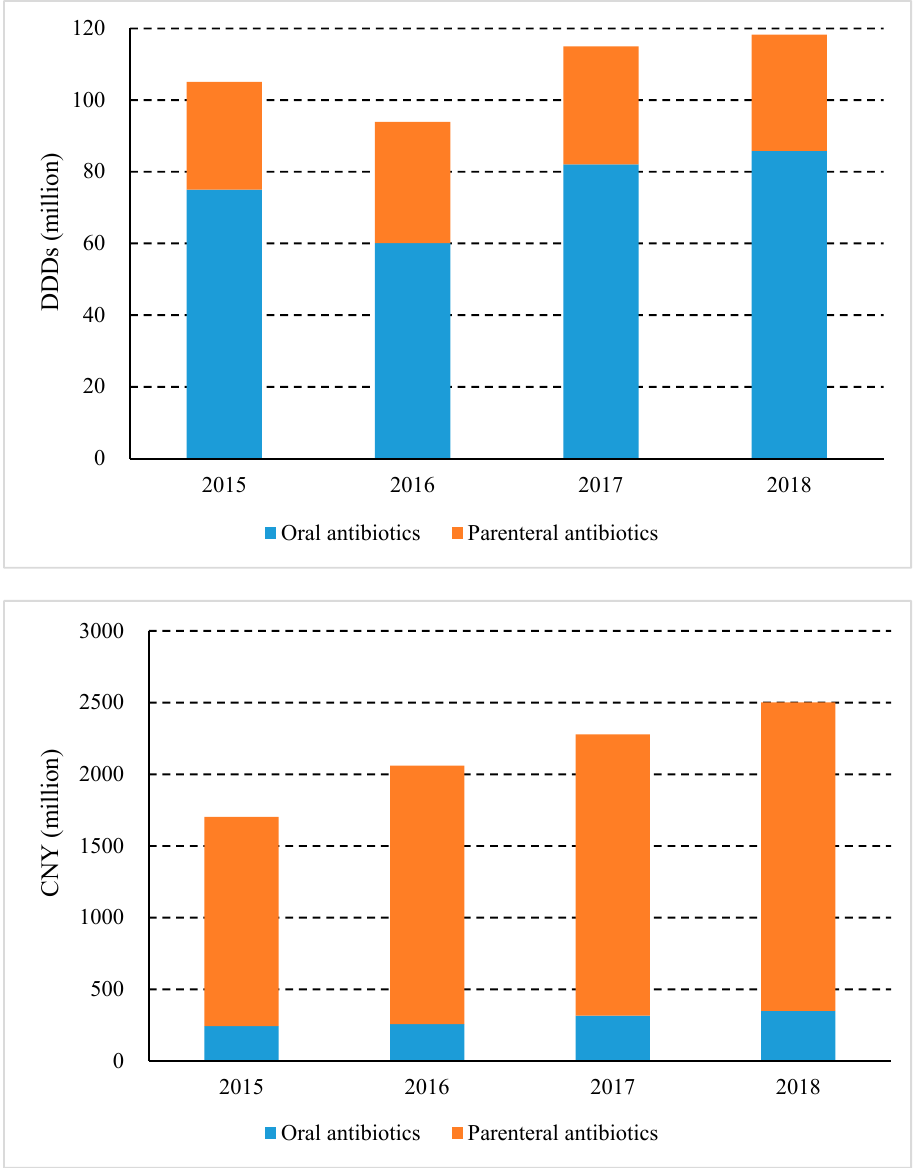
Figure 2. Consumption and expenditure of oral and parenteral antibiotics in Shaanxi Province, western china, 2015–2018. （ DDDs, defined daily doses; CNY, Chinese Yuan ）